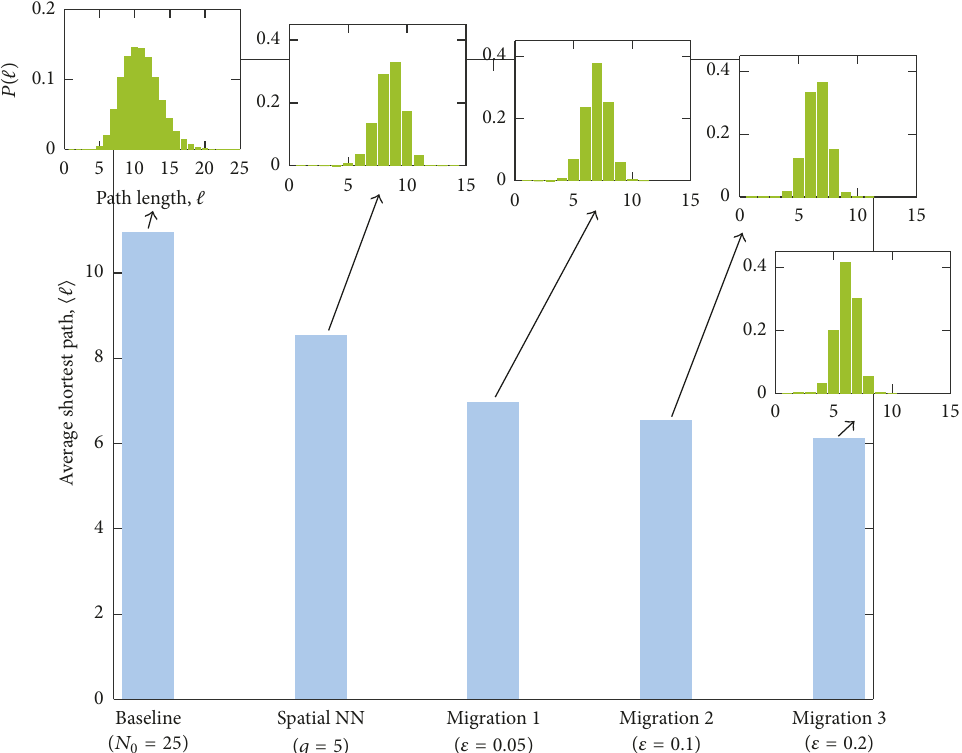
Figure 4: Statistics of shortest path length between all node pairs (𝑖,𝑗) where 𝑖 and 𝑗 belong to cities 1 and 2 as shown in Figure 2(b), indicating a decrease of the average path length as additional features are introduced into the model, as well as narrowing of their distribution (inset